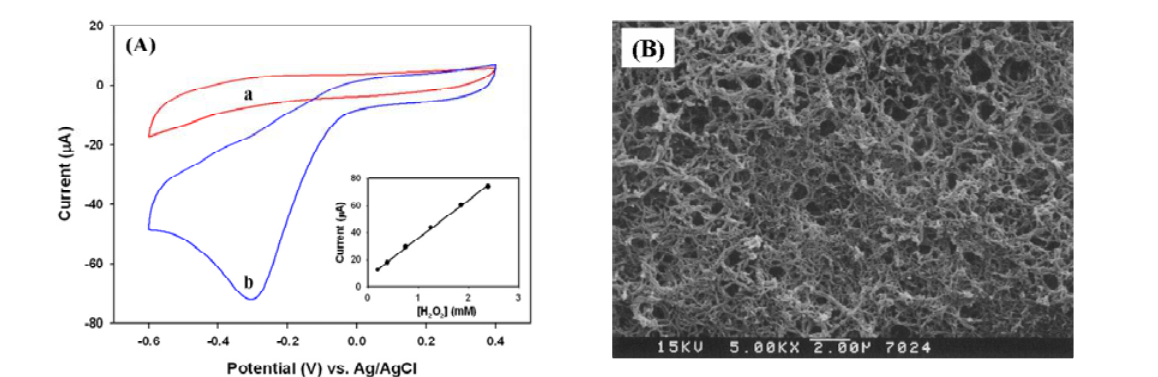
Figure 3 . (A) Cyclic voltammograms of PANI/Pt electrode (a) in the absence of H and (b) in the presence of 2.39 mM of H cathodic peak current at -0.32 V with the concentration of H PANI film on the Pt